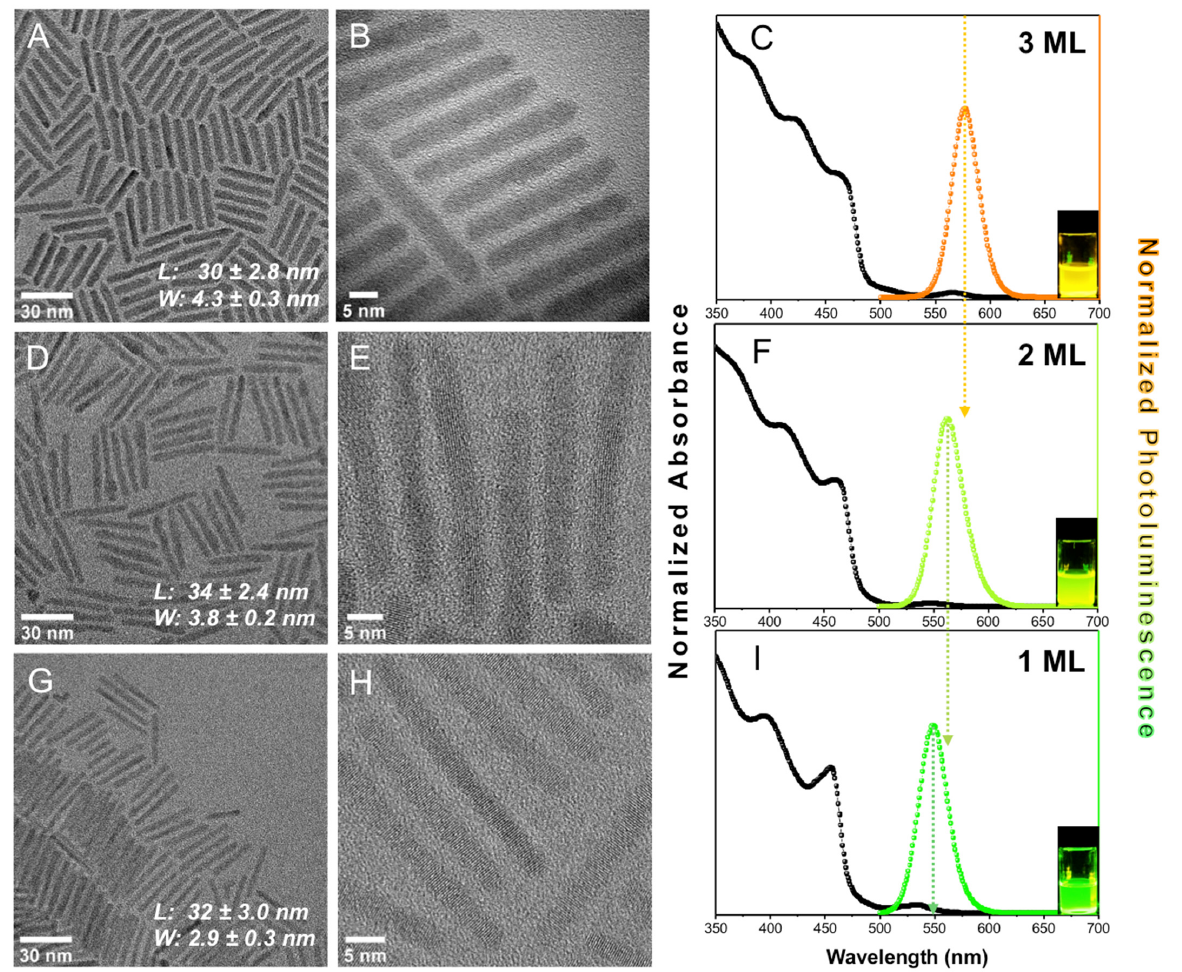
Figure 1. Optical characterizations of nanomaterials. TEM and UV-Vis absorption and PL spectra of 3 ML ( A – C ), 2 ML ( D – F ), and 1 ML ( G – I ) NRs in toluene, excitation wavelength 405 nm. The letters “L” and “W” in panels ( A , D , G ) are abbreviations for “length” and “width”, respectively. Insets in panels ( C , F , I ) show the luminescence of the different nanoparticles in solution with a glass vial. Photocatalytic hydrogen evolution reactions were performed to study the catalytic Two control experiments were conducted to validate the proposed photocatalysis activity of the 1, 2, and 3 ML NRs. The photocatalytic activity towards H 2 -production uti- cycle. For these control experiments, we focus on the mid-range 2 ML sample, which serves lizing nanorods was previously found as sensitive to the metal tip size, and potentially also the contact area [33]. Given the variation in rod widths, attaining the desired level of as a representative case. In the first control experiment (Figure 2A), each species was inde- control over the Pt domain size and interface diameter was beyond our reach. In order to pendently omitted. In the absence of any of the components—MV 2+ (redox shuttle), enable proper comparison between the various rods, the metal cocatalyst in this work had to be decoupled from the rods. Hence, Pt nanoparticles that were freely mixed with the rods were utilized, with methyl viologen (MV 2+ ; 4.5 mM) acting as an electron shuttle that transferred electrons from the photosensitized rods to the Pt nanoparticles (Pt-NPs; 0.8 mM), on which the reduction reaction took place [34]. 3-mercaptopropionic acid (MPA; 0.11 M) was used as both a water-dispersible ligand and as a hole scavenger. For further details, the reader is referred to the SI. The solution was dispersed in a phosphate buffer (pH 6.2, 50 mM) and placed inside of a custom-built gas tight reaction cell (details of which were published previously) [1]. The concentration of nanorods was adjusted to an optical density of 2.0 at 405 nm (~5–10 × 10 14 rods per sample, see SI for detailed explanation on